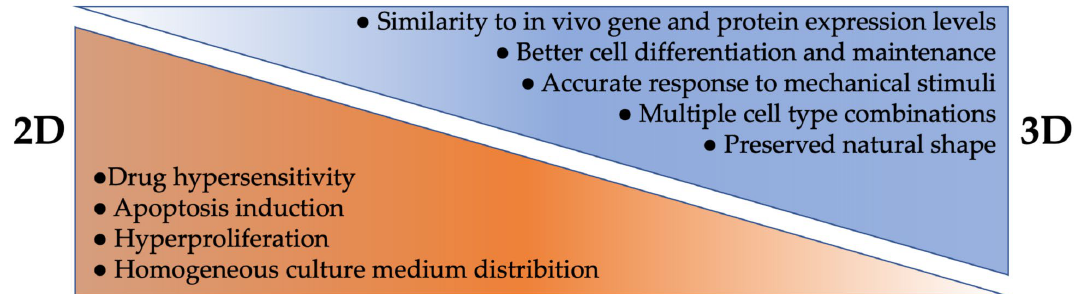
Figure 1. Main characteristics of in vitro cell culture methods performed in 2D versus 3D conditions.